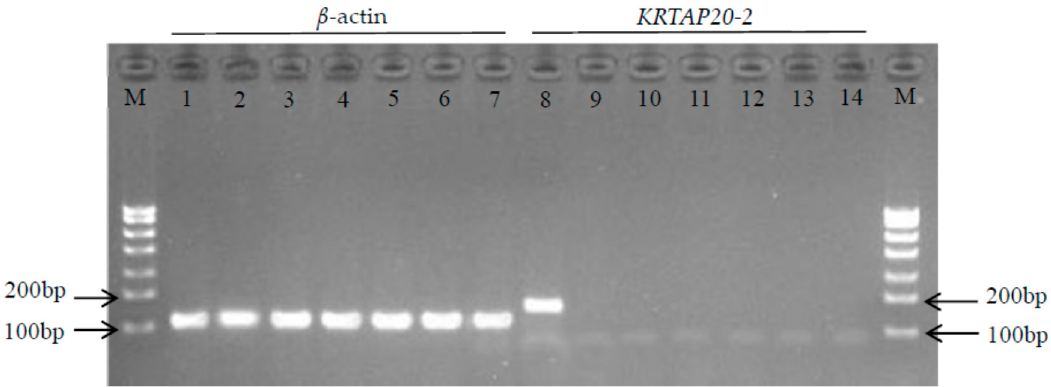
Figure 5. RT-PCR results of β -actin and KRTAP20-2 in seven tissues of Longdong cashmere goats. M: marker. Lanes 1–7 and 8–14 are expression results of β -actin and KRTAP20-2 in seven tissues, respectively. Numbers below lanes are tissues studied: 1 and 8: secondary hair follicle; 2 and 9: heart; 3 and 10: liver; 4 and 11: lung; 5 and 12: kidney; 6 and 13: spleen; 7 and 14: longissimus dorsi muscle.